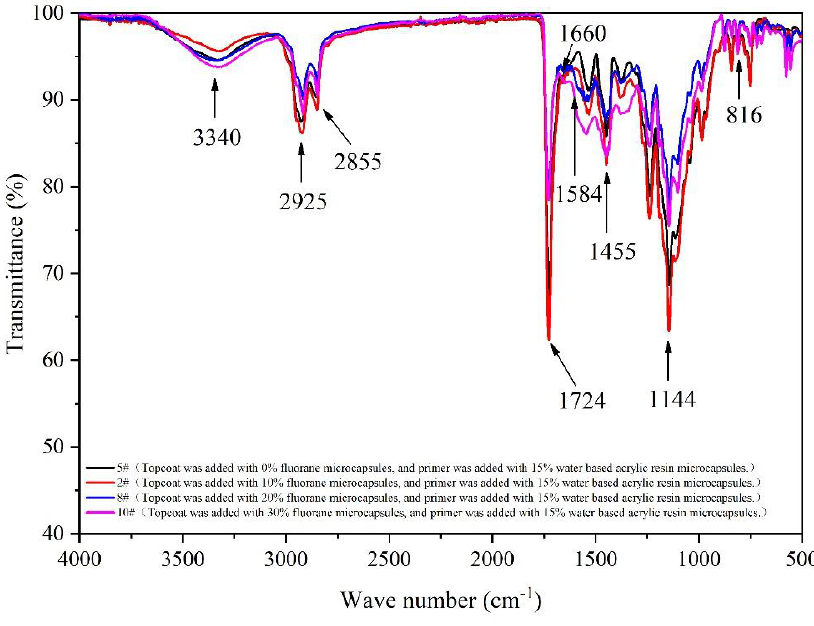
crocapsule content. It shows that there is no difference in the composition of the coating